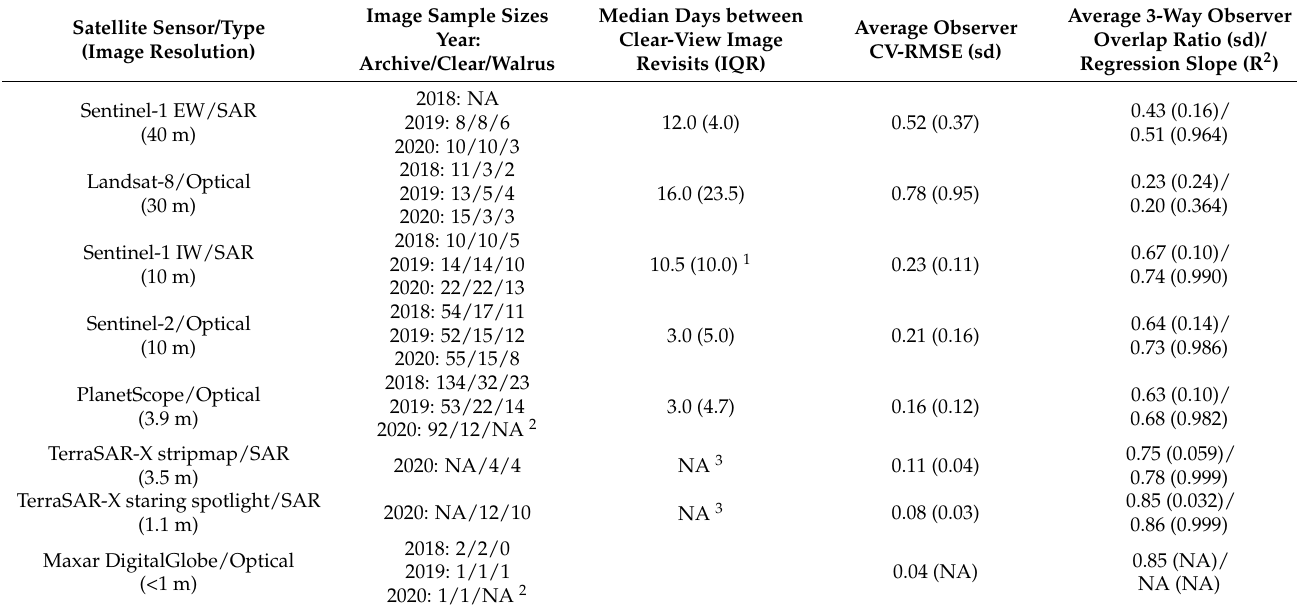
Table 1. Summary of sample sizes, clear-view revisit rates, and observer variations in detecting and delineating walrus aggregations using different types of satellite imagery. Image sample sizes are provided for the total number of archived images, number with a clear view of the study area, and number with walruses detected. Revisit intervals were calculated using only clear-view images, and one per day for PlanetScope. Sample sizes for the average CV-RMSE, average overlap, and regression slope were the number of images with detected walruses pooled across years. All linear regression slopes were statistically significant (P < 0.0001) except for Landsat-8 (P >